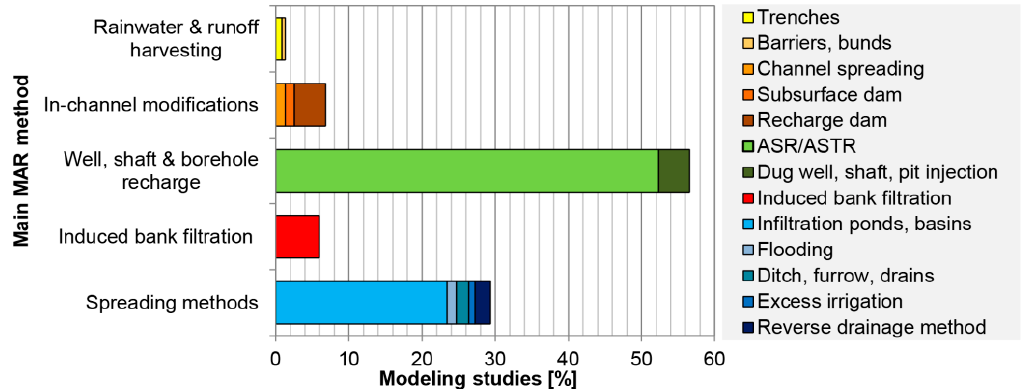
Figure 1. Distribution of modeling studies (%) for the main MAR techniques and MAR subtypes used (literature studies may involve multiple MAR techniques).